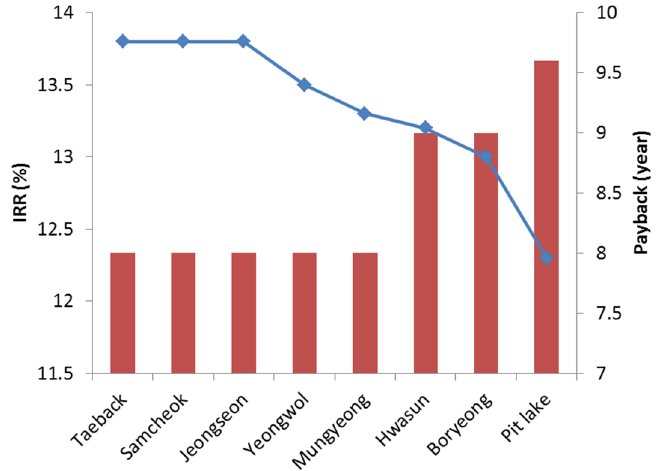
Figure 7. Internal rate of return (IRR) and payback year from photovoltaic systems at seven abandoned districts in Korea and the pit lake. Blue line with diamond points indicate payback year. The bar graph is of IRR values.